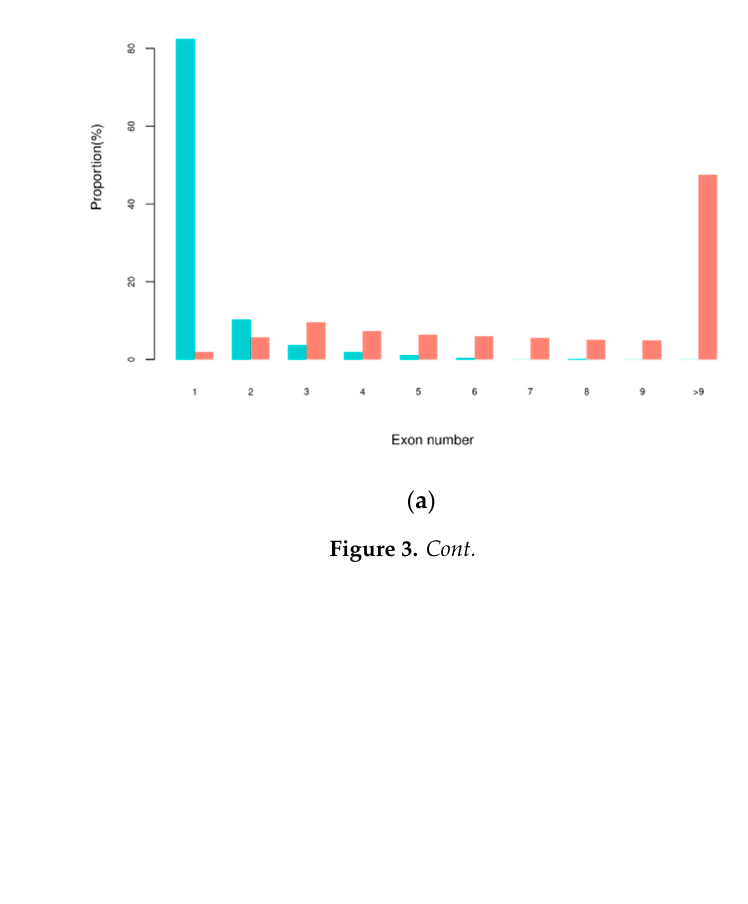
Figure 2. Different class codes of expression level of skeletal muscle lncRNAs. potentially novel isoform (fragment): at least one splice junction is shared with a reference transcript; i: a transfrag falling entirely within a reference intron; o: generic exonic overlap with a reference transcript; u: unknown, intergenic transcript; x: exonic overlap with reference on the opposite strand; WB, WT, SB, and ST represent WuTou donkey longissimus dorsi muscle, WuTou donkey gluteus muscle, SanFen donkey longissimus dorsi muscle and SanFen donkey gluteus muscle, respectively.